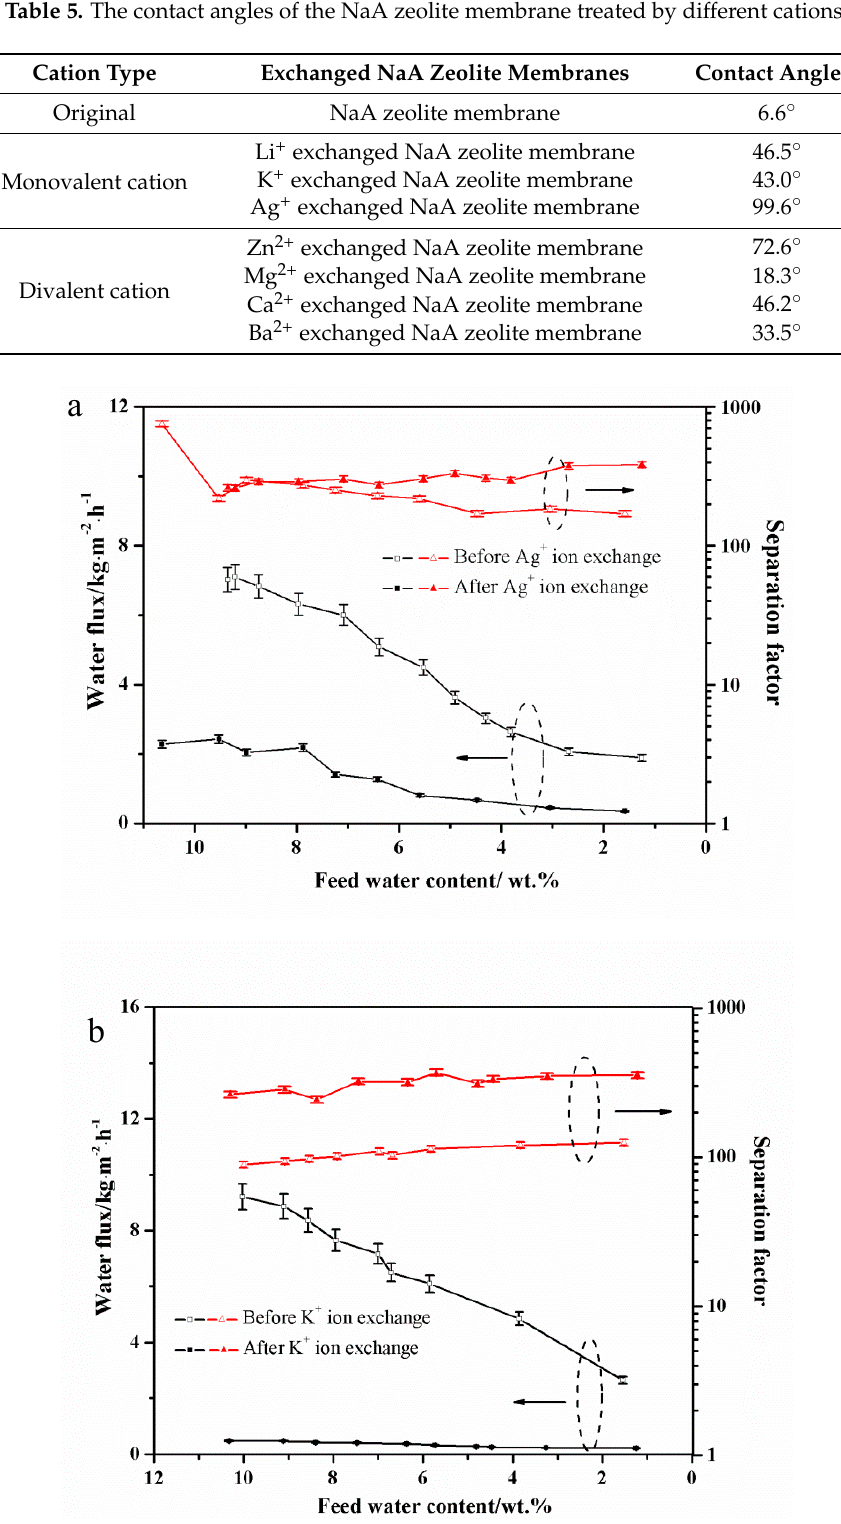
Figure 11. Vapor permeation (VP) dehydration of different ethanol/water mixtures using salt treated NaA zeolite membrane. ( a ) AgNO 3 solution and ( b ) KCl solution, where the vapor pressure was 1.4 bar under a temperature of 100 °C.